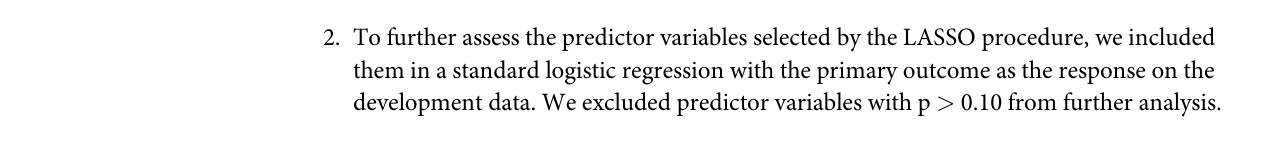
2. To further assess the predictor variables selected by the LASSO procedure, we included them in a standard logistic regression with the primary outcome as the response on the development data. We excluded predictor variables with p > 0.10 from further analysis.